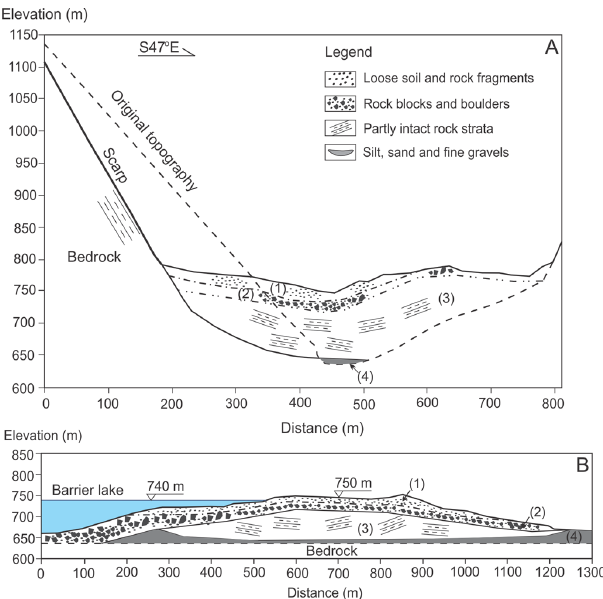
Fig. 3. (A) Geological profile (A–A 0 in Fig. 2) of the Tangjiashan landslide; (B) Longitudinal cross-section of the dam body along the valley showing four-layered structure, modified based on Chengdu Hydroelectric Investigation and Design Institute (CHIDI) in China (2008) and Xu et al.